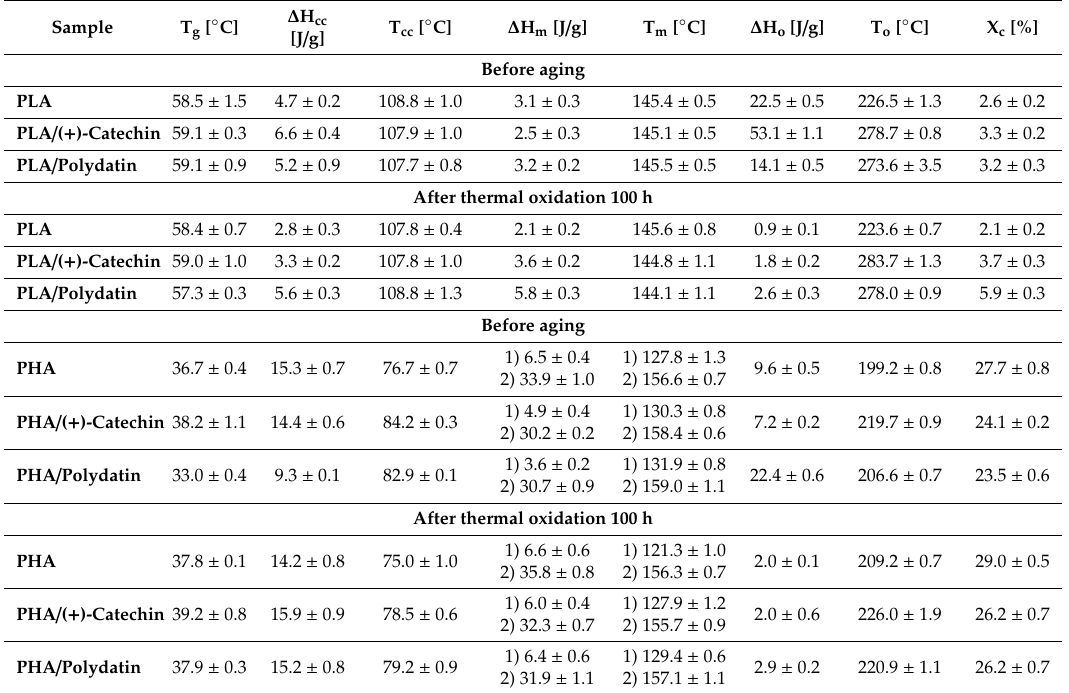
Table 2. The DSC analysis of the PLA and PHA samples with plant polyphenols before and after thermal oxidation